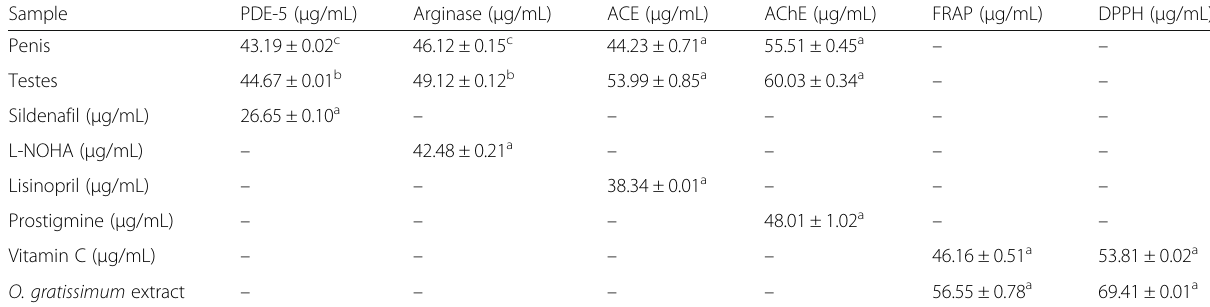
Table 1 IC 50 values ( μ g/mL) of ferric reducing power, DPPH, PDE-5, arginase, ACE and AChE inhibitory activities in rat penile and testicular tissue by O. gratissimum leaf extracts and standard drugs/inhibitors